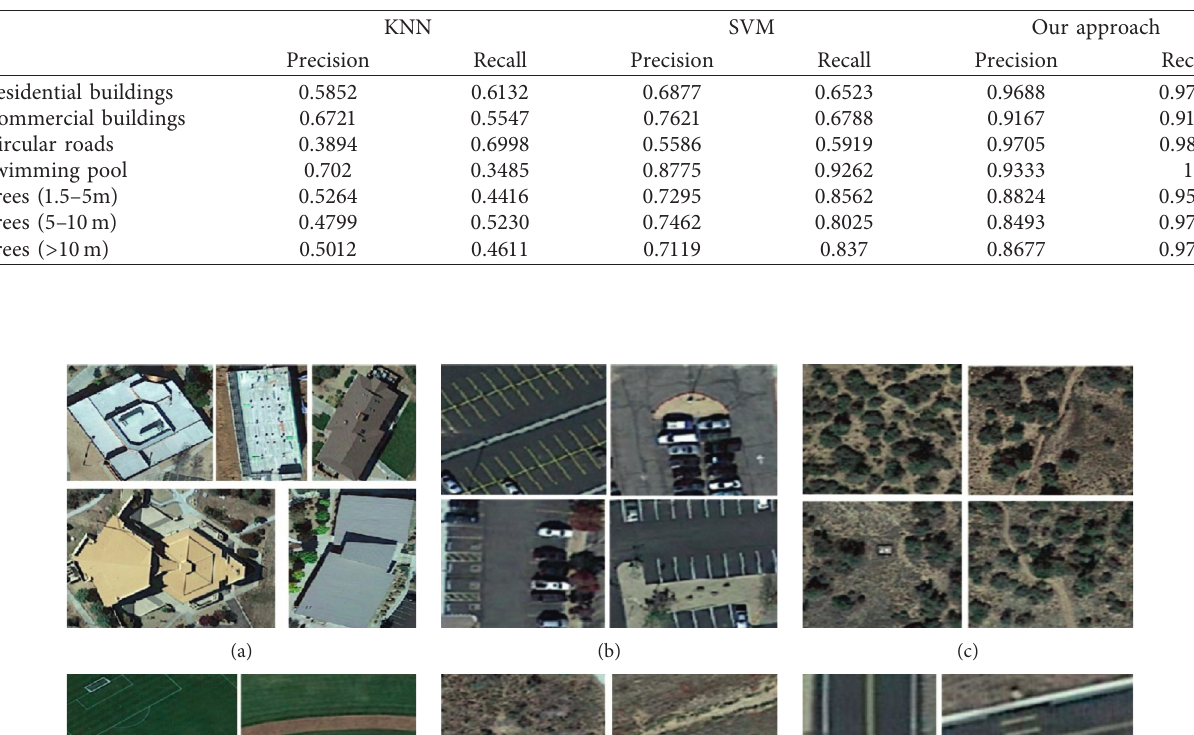
Table 4: Quantitative evaluation of recognition results based on the first experimental datasets.